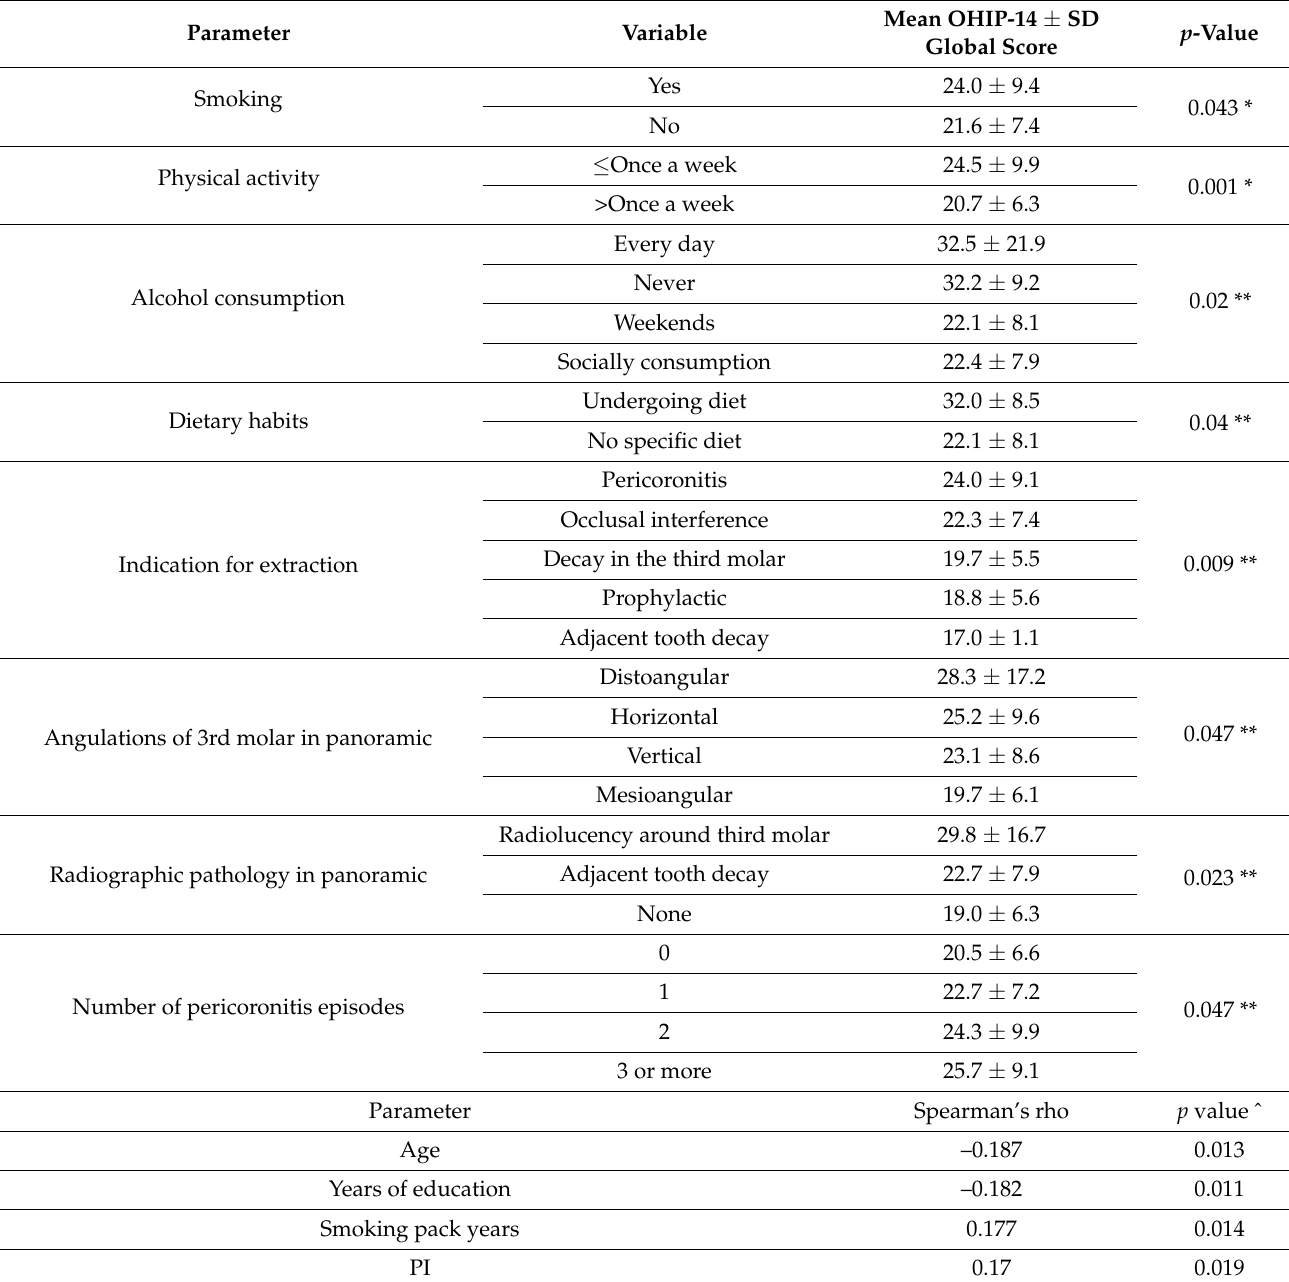
Table 4. Associations of pre-operative OHIP-14 global score with statistically significant parameters among the study population (* independent t test, ** ANOVA, ˆ Spearman’s